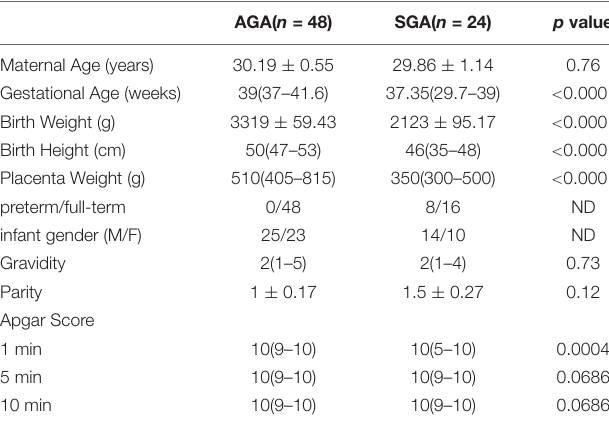
TABLE 1 | Demographic data of AGA and SGA